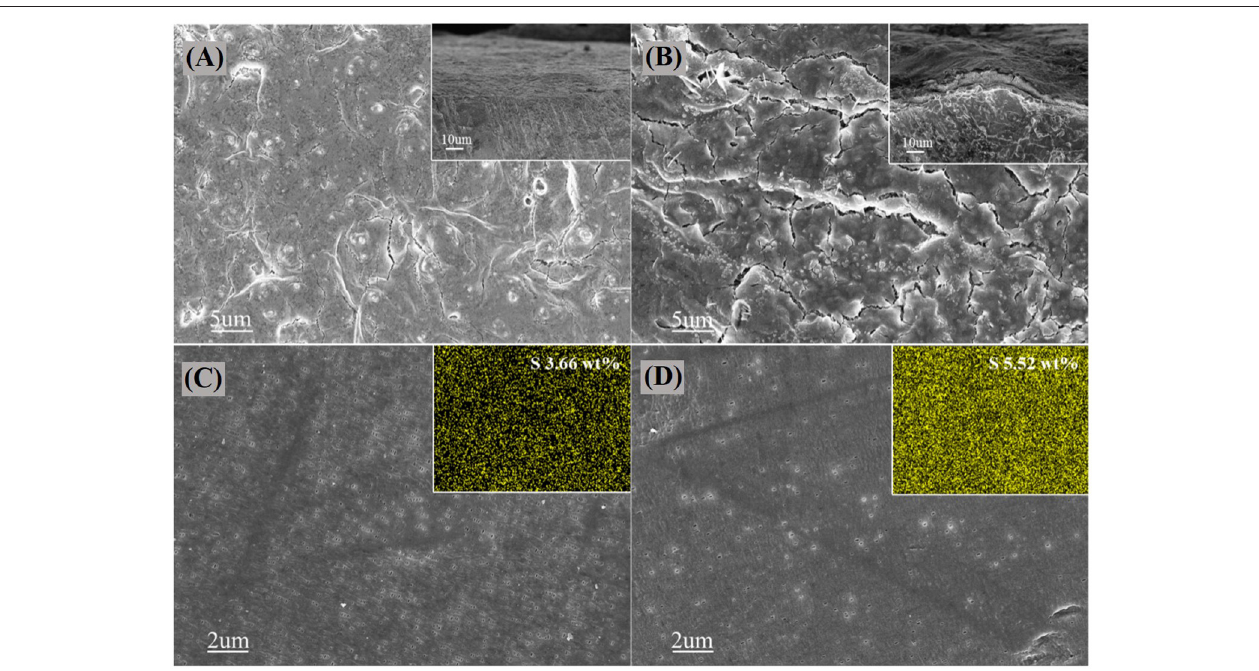
FIGURE 6 | SEM images on the surface and cross-section of cycled lithium foil of (A) PGBs@S and (B) G@S batteris; SEM images and EDS mapping of the separator surface facing lithium foil side in (C) PGBs@S and (D) G@S